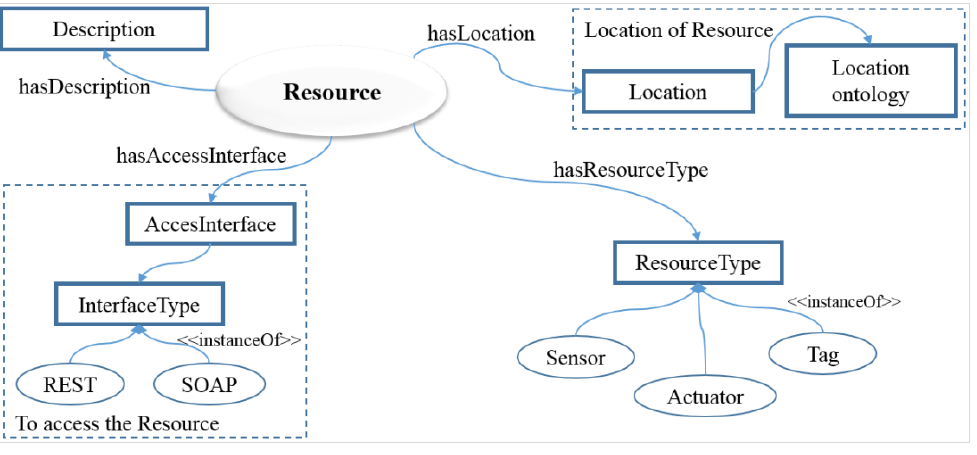
Figure 8. The resource model defines resource information in the semantic ontology to provide resource information to the service